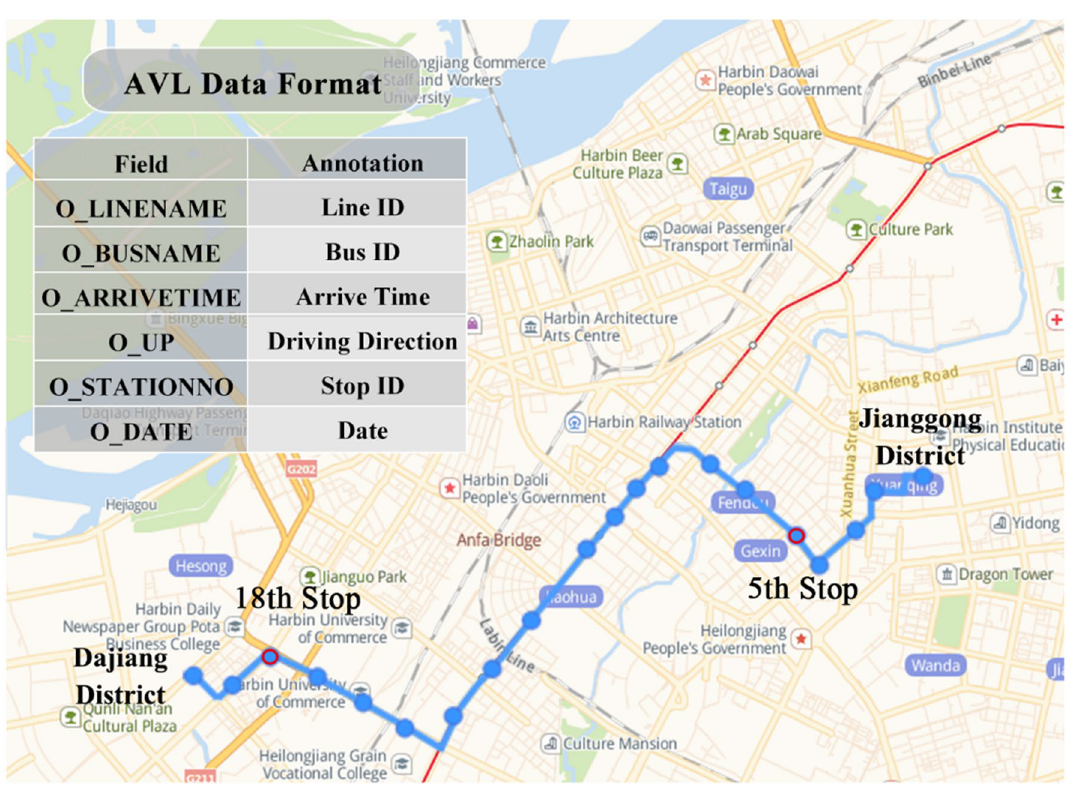
Fig. 1 Route of the No. 63 bus line